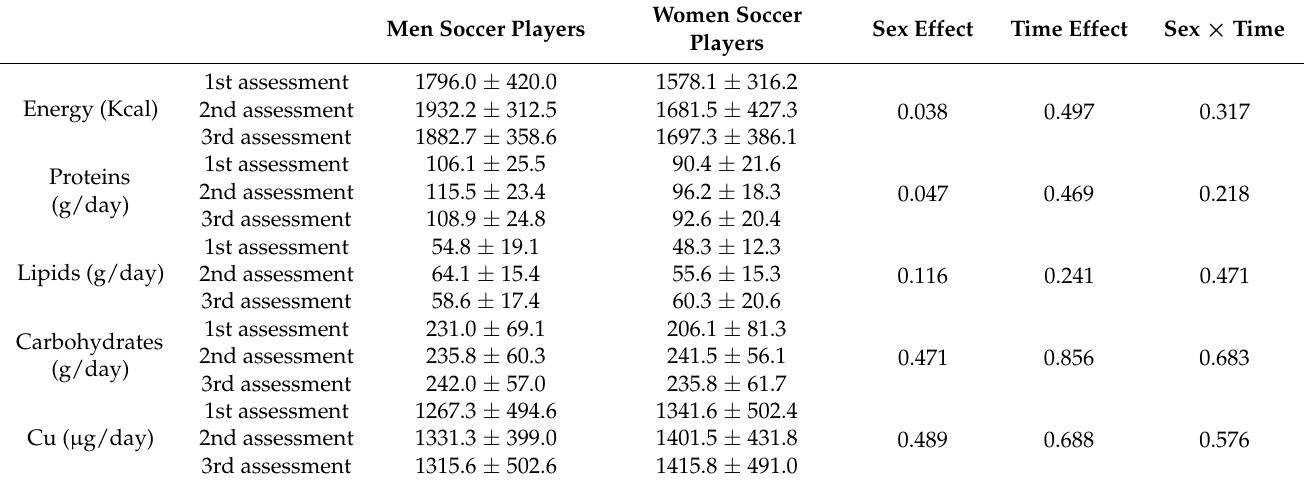
Table 6. Mean intake of the three days of evaluation of macronutrients and Cu throughout the study.